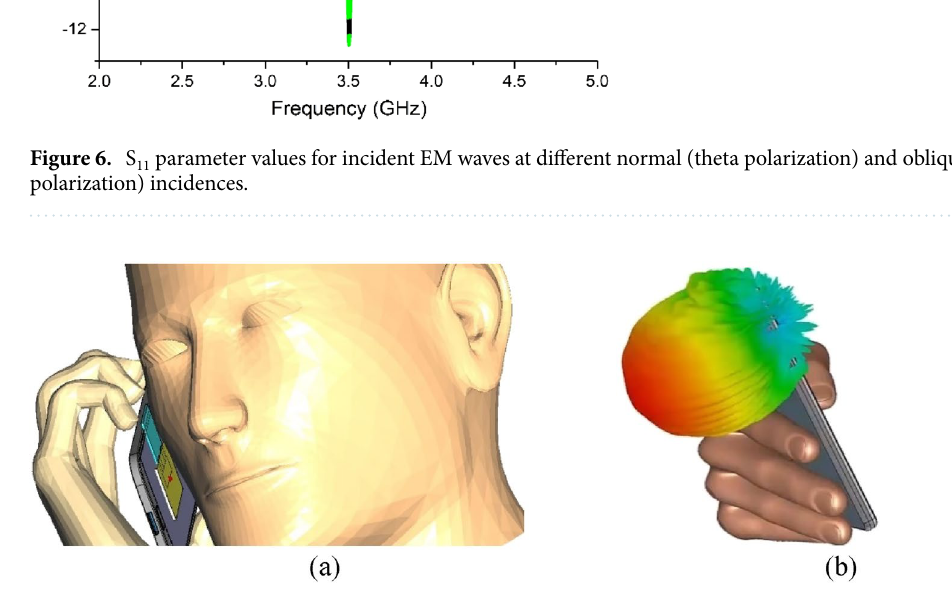
Figure 7. ( a ) Simulation setup of the 5G antenna and the designed MMA inside a mobile phone with human head and hand phantom (blue—antenna, yellow—MMA), ( b ) 3.5 GHz antenna radiation direction. [The